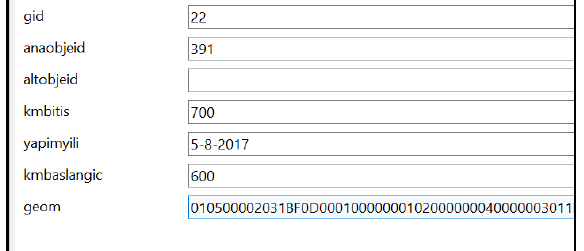
Figure 17. Representation of attribute and spatial data of a sample road disturbance